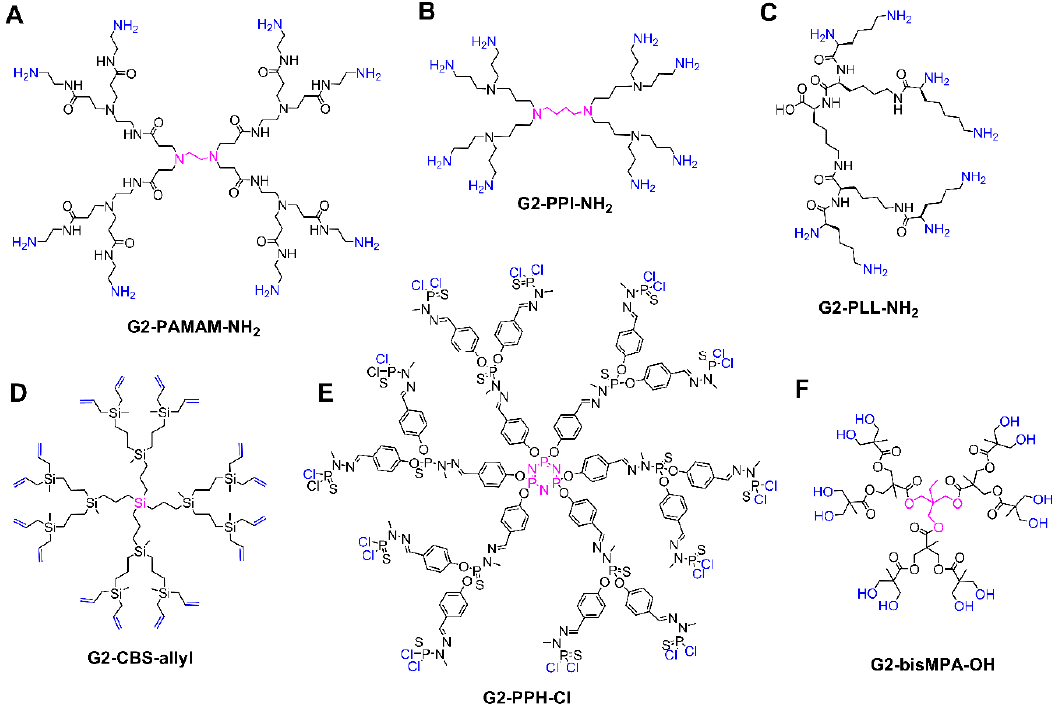
Figure 2. Overview of the most common dendritic families for biomedical applications, depicting the structure of second generation dendrimers. ( A ) Poly(amino amide) (PAMAM). ( B ) Poly(propylene imine) (PPI). ( C ) Poly(L-lysine) (PLL). ( D ) Carbosilane (CBS). ( E ) Poly(phosphorhydrazone) (PPH). ( F ) Bis-MPA polyester. The core is highlighted in pink, the terminal groups in blue.